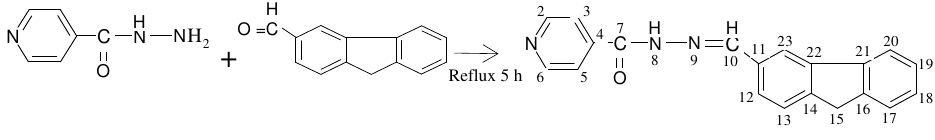
Figure 1. The synthesis of the isonicotinoylhydrazone-2-aldehydefluorene (INHAF)